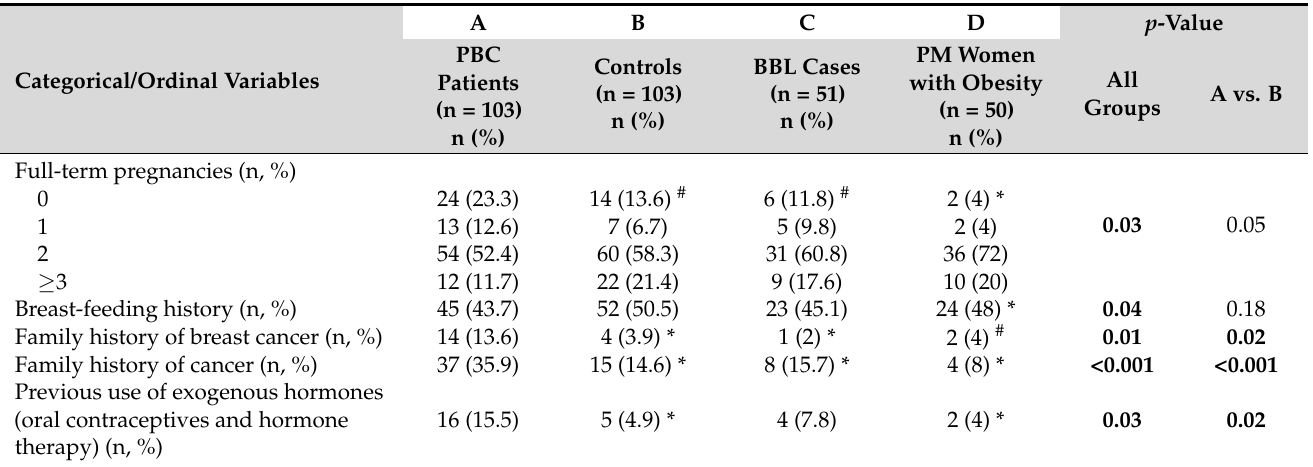
Table 1. Descriptive categorical/ordinal and continuous features of postmenopausal breast cancer (PBC) patients (n = 103), healthy control subjects (n = 103), cases with benign breast lesions (BBL) (n = 51), and postmenopausal (PM) women with obesity (n =